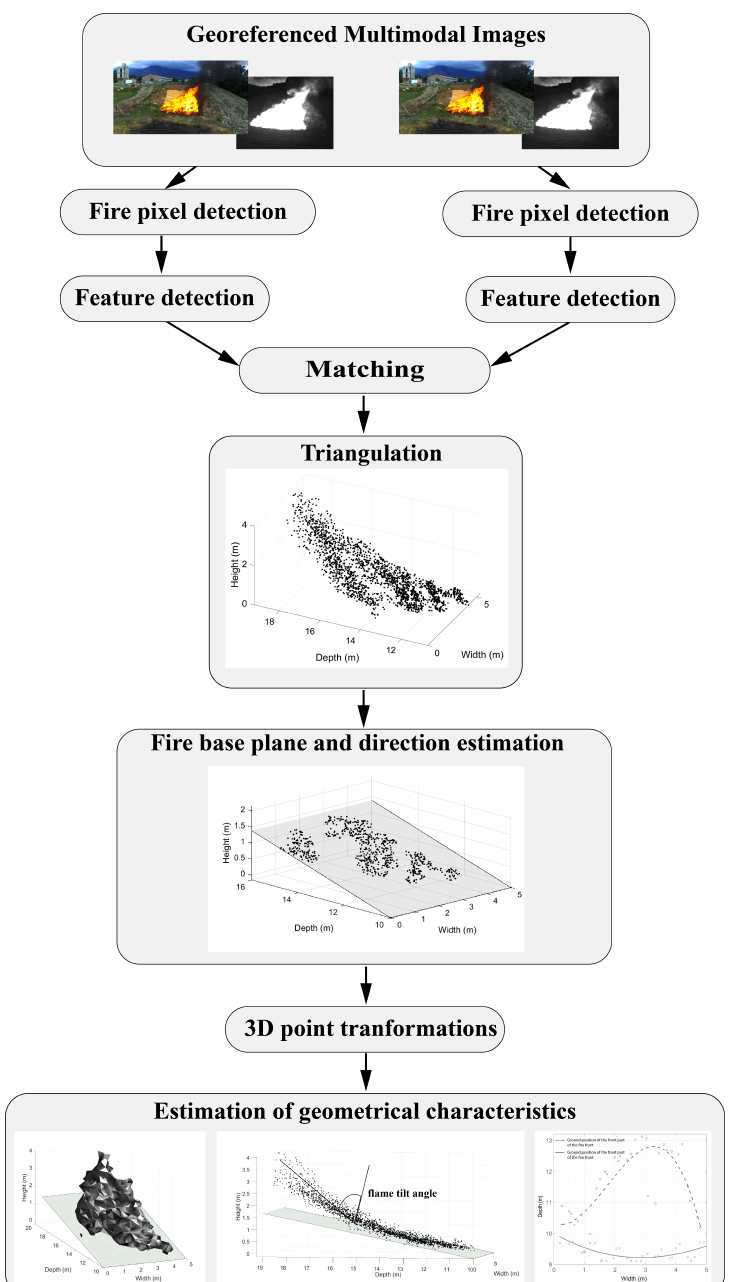
Figure 2. Diagram of the proposed